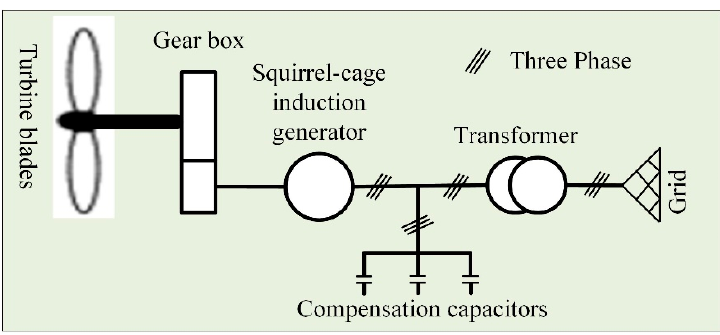
Figure 3. Fixed-speed wind turbine induction generator.